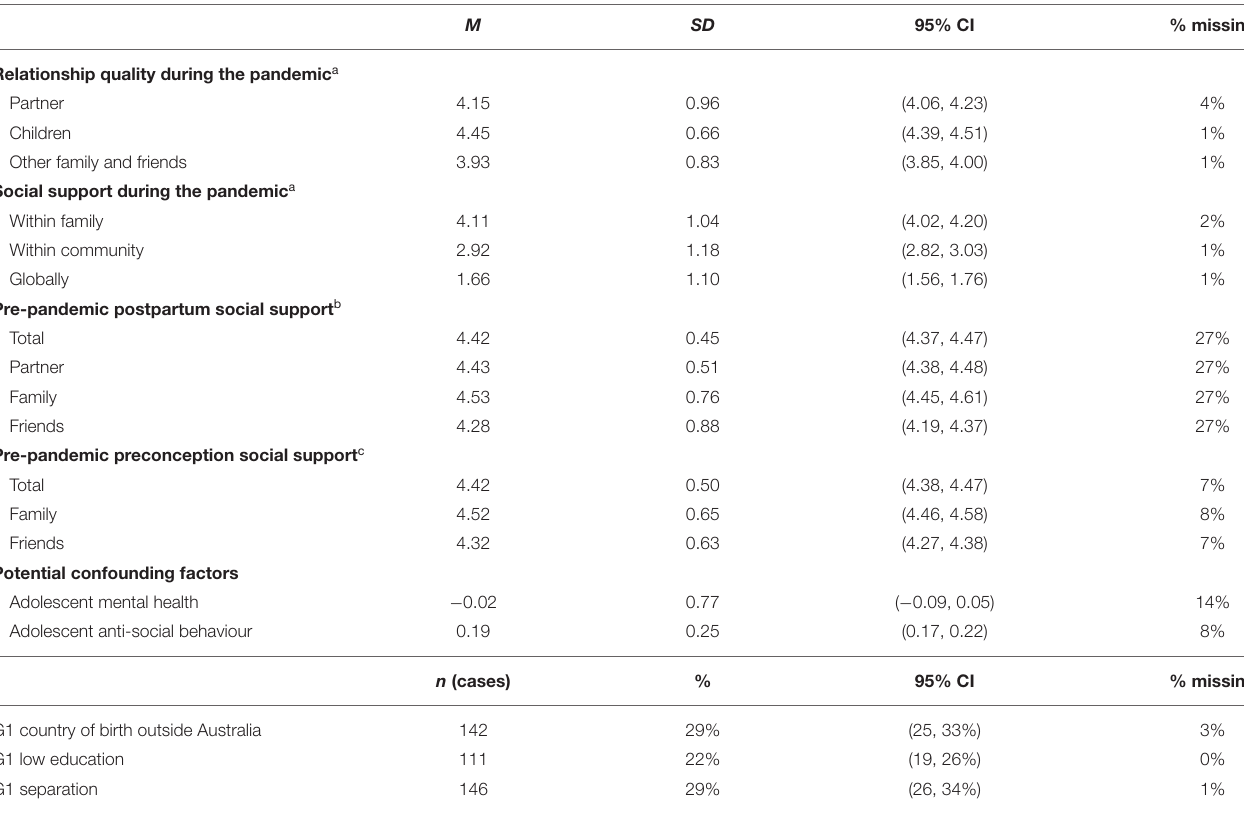
TABLE 1 | Descriptive statistics for COVID-19 outcomes, pre-pandemic exposures and potential confounding factors in the unimputed data ( n = 502 parents of 871 children). M SD 95% CI %